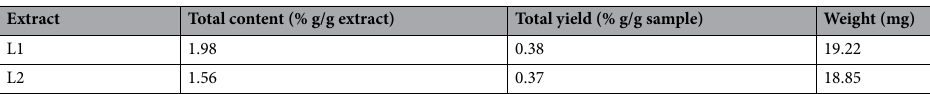
Table 9. Ethanol residue content in dried P. niruri extract. L1: P = 200 bar, T = 60 °C, 50% ethanol–water co-solvent, L2: P = 262 bar, T = 80 °C, 30% ethanol–water co-solvent.